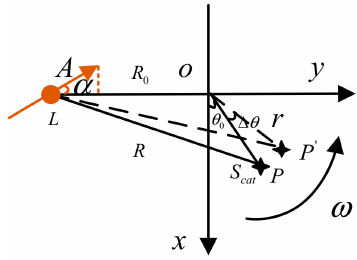
Figure 1. ISAL turntable imaging